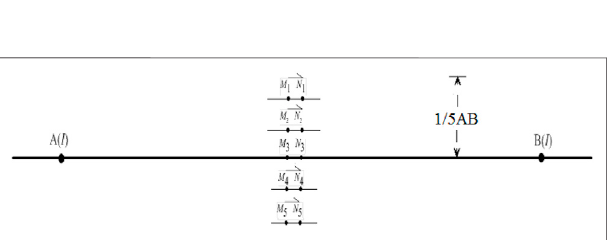
FIGURE 5 | Sketch map of the intermediate gradient device of the DC method.